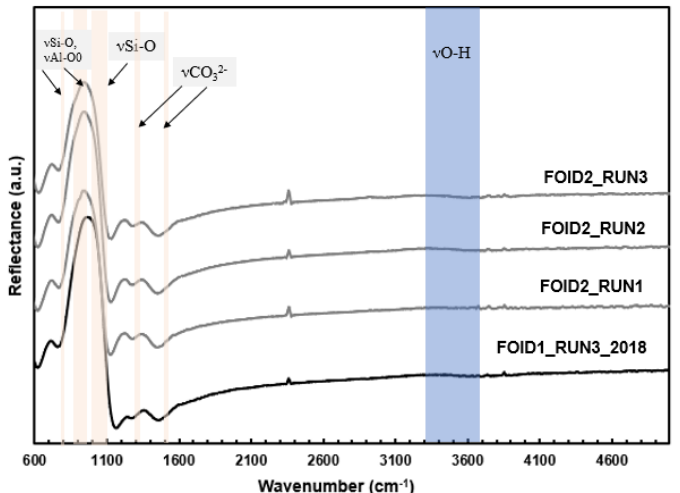
Figure 4. Background subtracted infrared reflectance spectra of the recovered glasses. The pink shaded areas are taken as reference by King et al. [35] for the Si–O and CO 3 2 − bands. The blue shaded area refers to the frequency where a negative peak indicative of the presence water molecules is expected. Moreover, small peaks, appearing near to 3600 cm − 1 , are due to atmospheric water vapor not fully compensated.